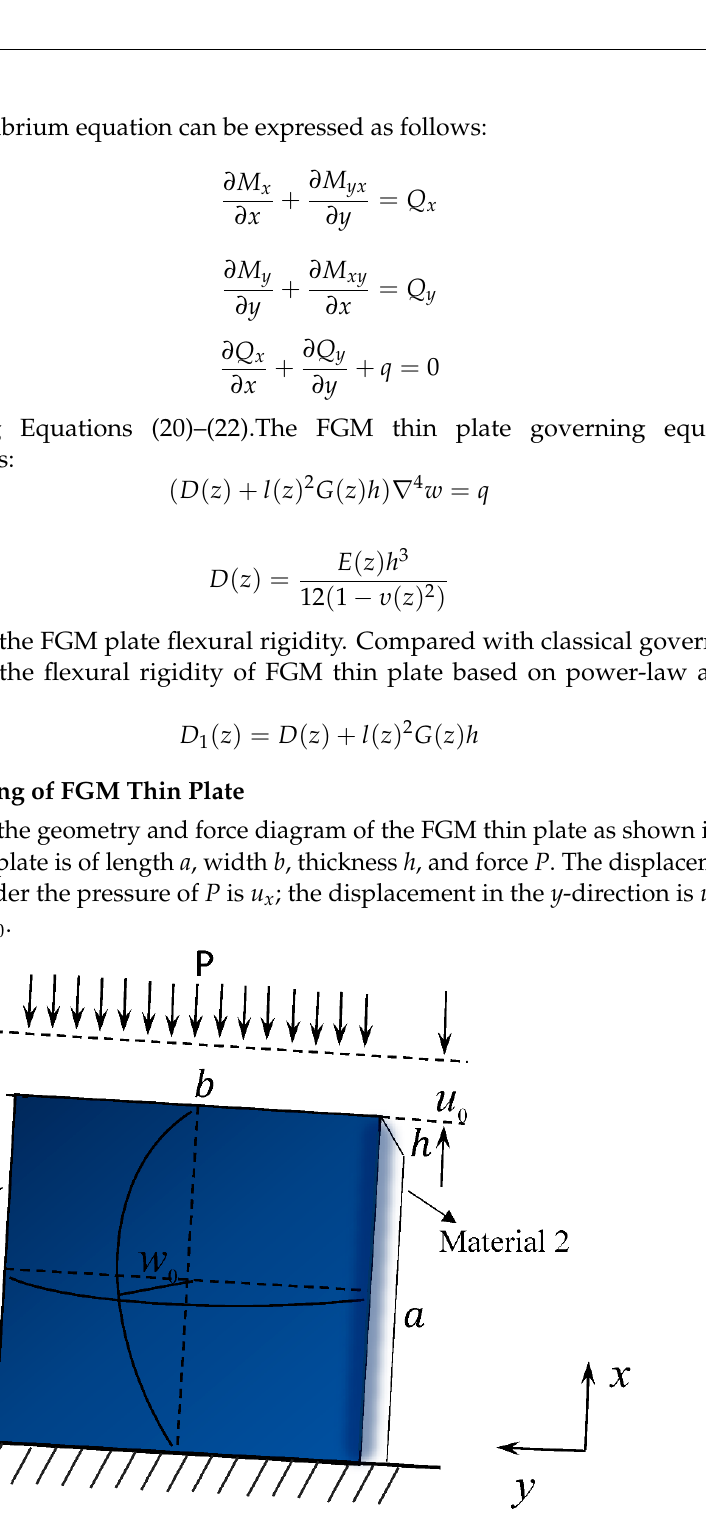
Figure 2. Loading and geometry of an FGM thin rectangular plate